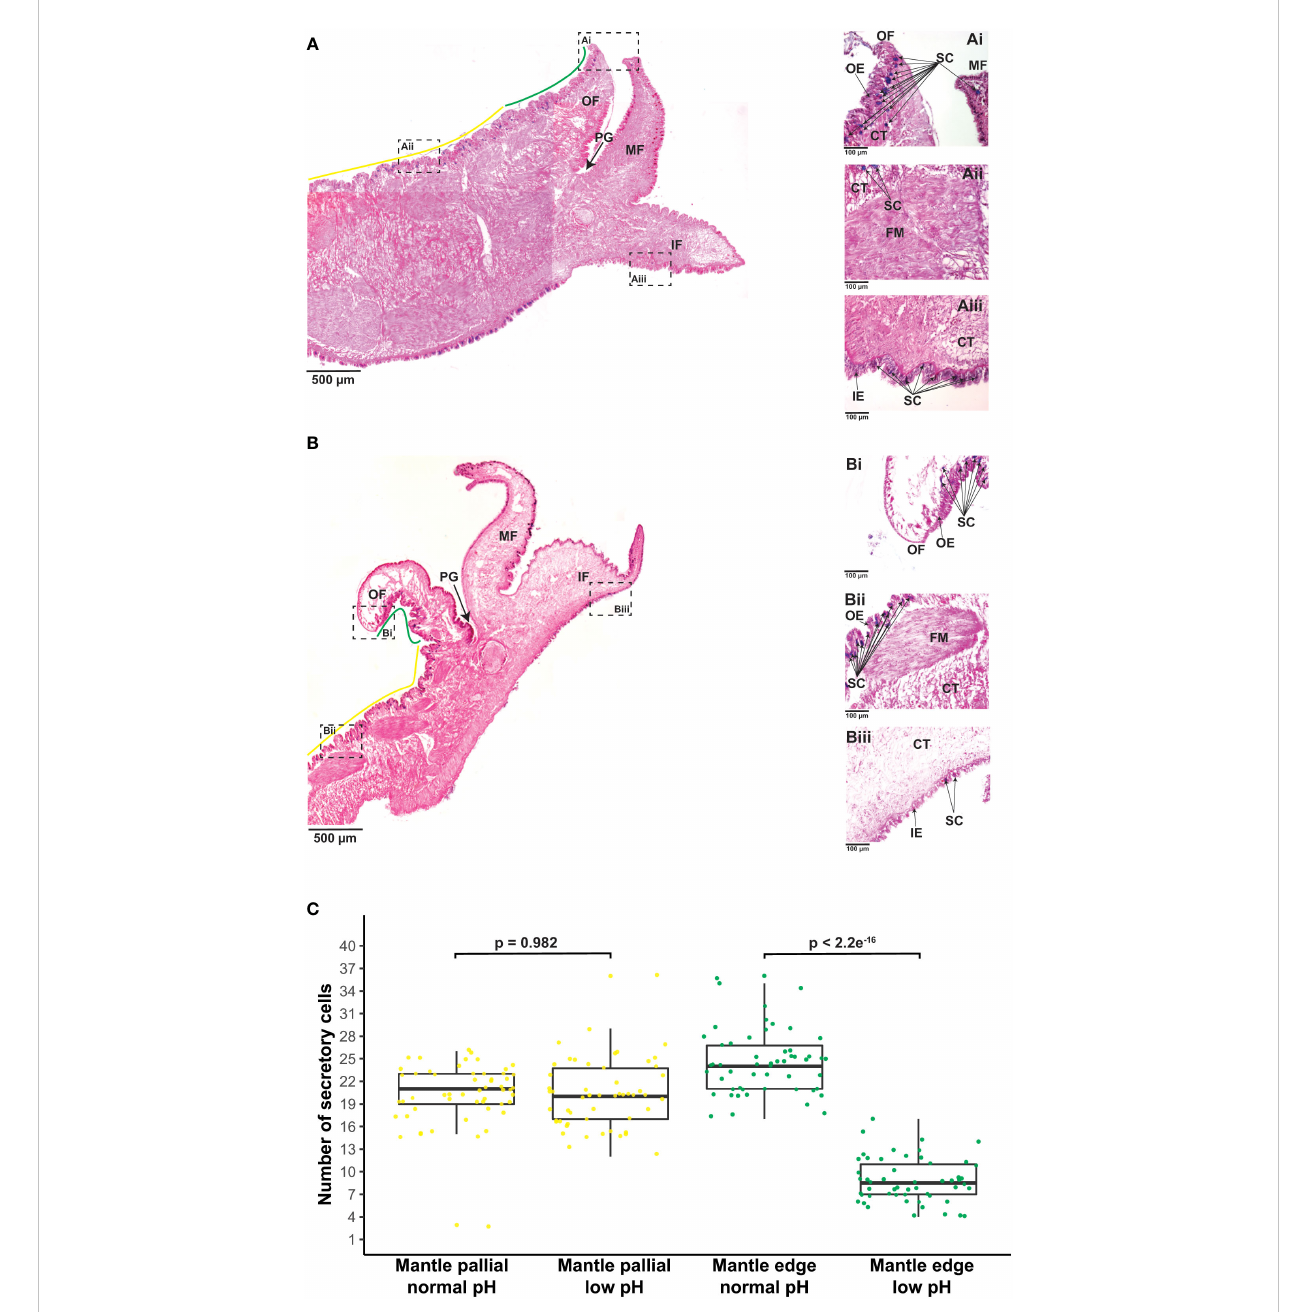
FIGURE 3 Effect of ocean acidi fi cation on the secretory activity of mantle cells. (A) Example of Alcian Blue-stained section through the mantle tissue of one adult individual of C. gigas kept under normal pH (8.0 ± 0.2) condition showing the mantle edge (green line) and mantle pallial (yellow line) morphogenetic zones. Scale bar = 500µm. In addition, three mantle regions are shown to indicate: (Ai) A region of the outer fold belonging to the mantle edge zone, highlighting secretory cells in blue. Scale bar = 100µm. (Aii) A region of the outer epithelium belonging to the mantle pallial zone, showing secretory cells in blue. Scale bar = 100µm. (Aiii) A region of the inner fold that shows secretory cells in blue. Scale bar = 100µm. (B) Example of Alcian Blue-stained section through the mantle tissue of one adult individual of C. gigas kept under low pH (7.6 ± 0.2) condition showing the mantle edge (green line) and mantle pallial (yellow line) morphogenetic zones. Scale bar = 500µm. Three mantle regions are also shown to indicate: (Bi) A region of the outer fold belonging to the mantle edge zone, highlighting secretory cells in blue. Scale bar = 100µm. (Bii) A region of the outer epithelium belonging to the mantle pallial zone, showing secretory cells in blue. Scale bar = 100µm. (Biii) A region of the inner fold that shows secretory cells in blue. Scale bar = 100µm. OF, outer fold; PG, periostracal groove; MF, middle fold; IF, inner fold; OE, outer epithelium; CT, connective tissue; FM, fi bers muscle; IE, inner epithelium; SC, secretory cells. (C) Number of secretory cells along the outer epithelium covering the mantle edge and mantle pallial zones in adult oysters kept under normal and low pH conditions. Yellow dots indicate secretory cells found in the mantle pallial zone, whereas green dots correspond to secretory cells in the mantle edge